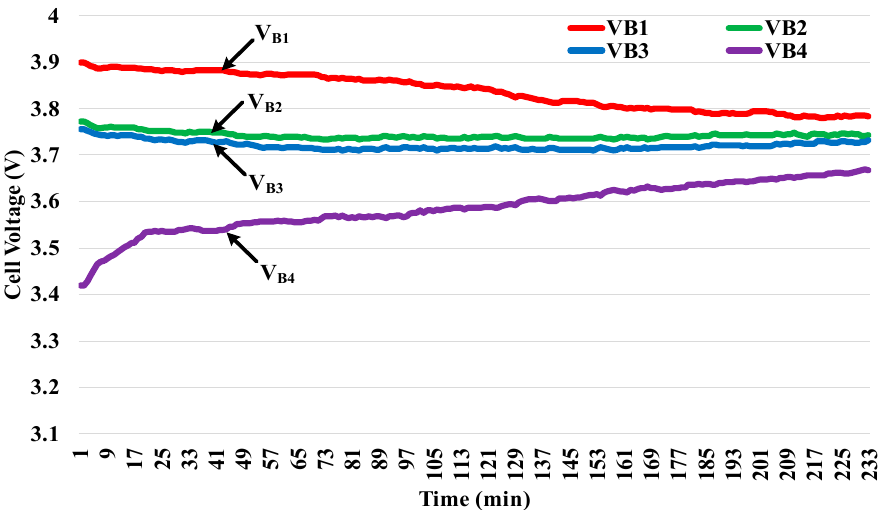
Figure 18. Voltage balance curve operated by the FDC method.